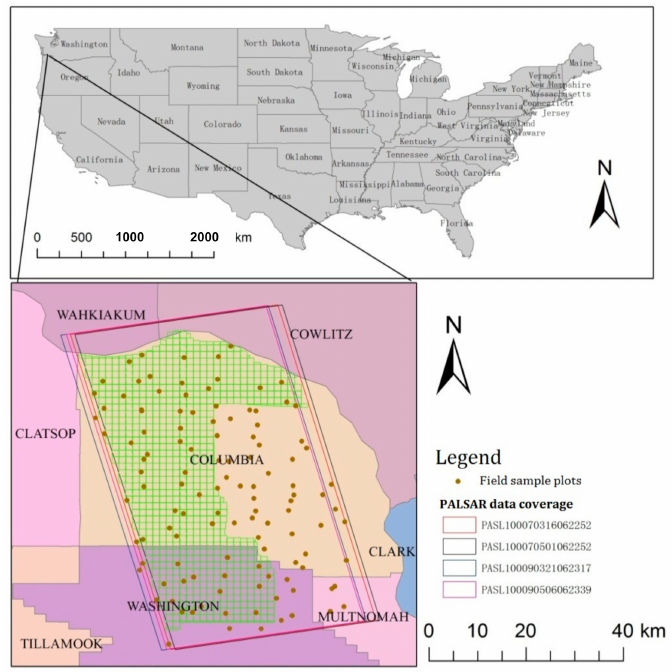
Figure 1. The spatial distribution of the field sample plots and remote-sensing data.